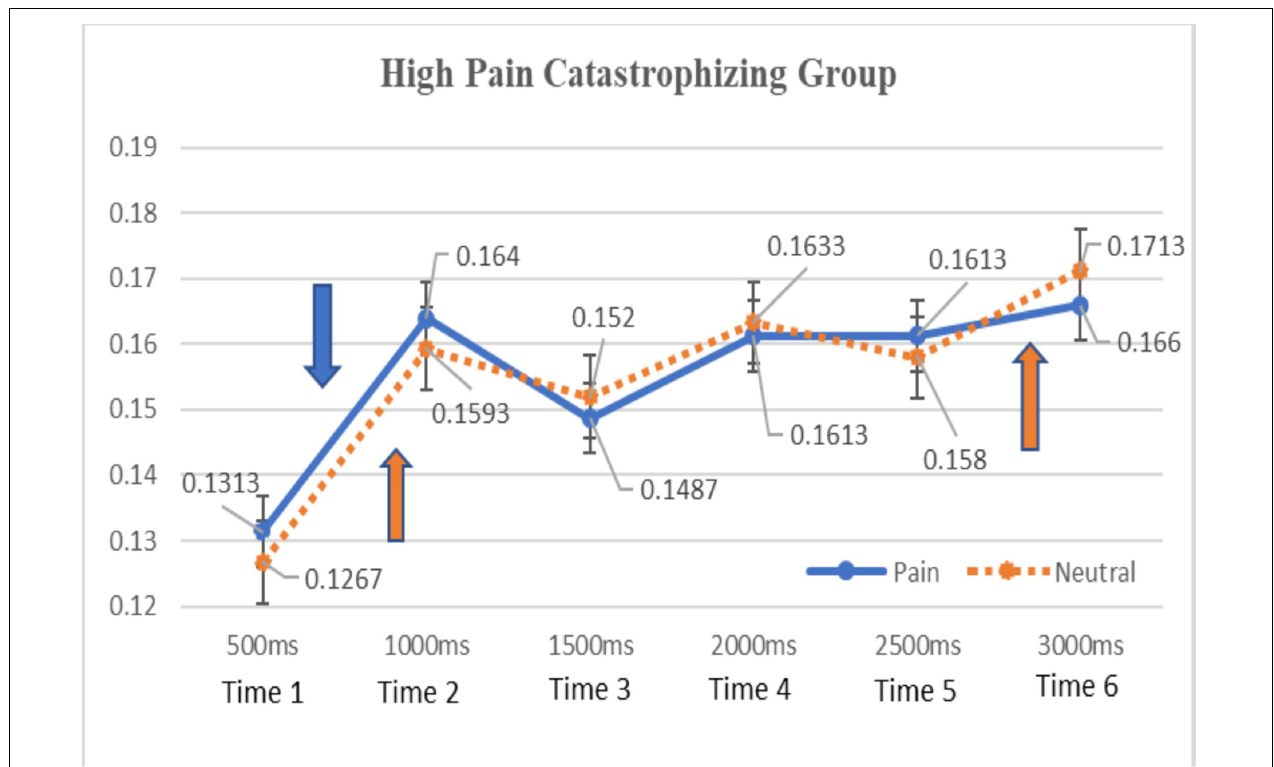
FIGURE 1 | Means of total gaze durations to pain and neutral facial stimuli by time (high pain catastrophizing group). Means of total gaze durations for pain and neutral stimuli were labeled and standard deviation bars were also included for each time point. Down-arrow symbol = a significant difference in gaze duration of pain stimuli between time 1 and 2. Up-arrow symbols = significant differences in gaze durations of neutral stimuli in time 1–2 and time 5–6. No significant differences were found between pain and neutral stimuli for all time